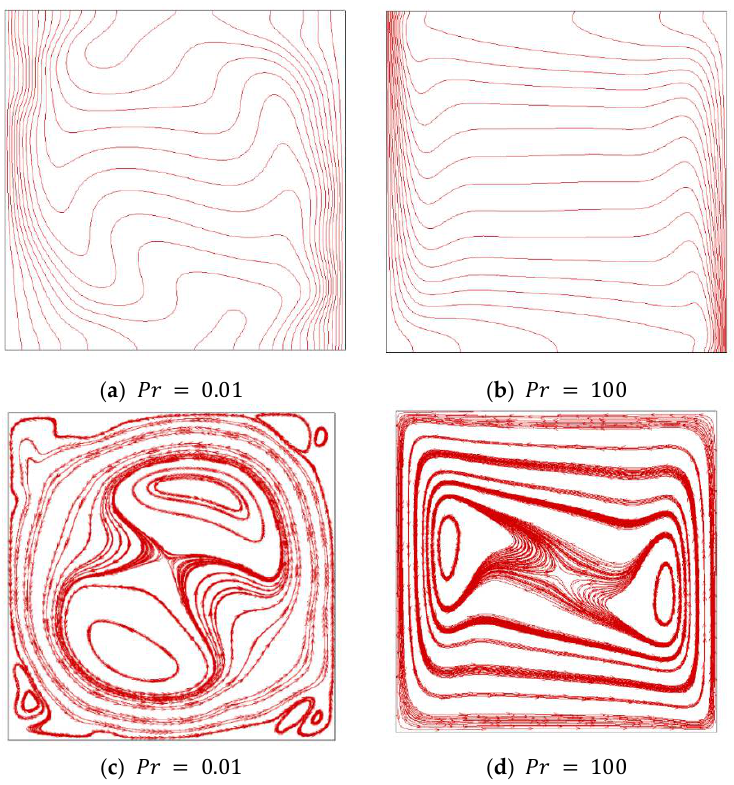
Figure 4. Isotherms ( a , b ) and streamlines ( c , d ) for different Pr with Ra = 10 6 . The results for